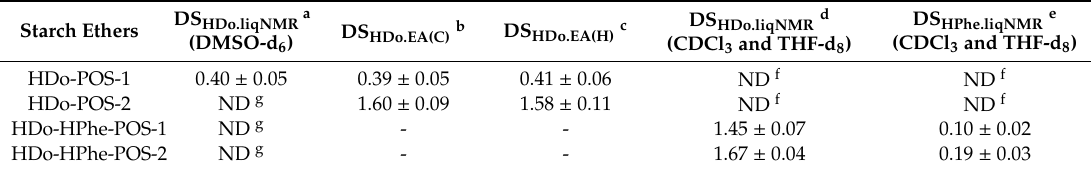
Table 3. Degrees of substitution of starch ethers determined by di ff erent